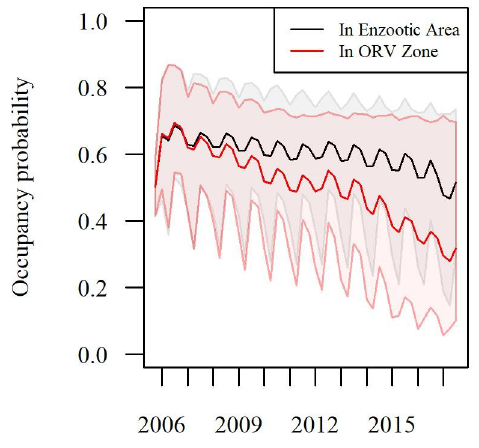
Figure 2. The Probability of RABV occupancy from 2006 to 2017 in the northern counties of New York, Vermont and New Hampshire. The estimates are shown by season and by status of areas within the ORV management zone (red) and those south of the ORV management zone in the enzootic area (black). The shaded regions by color show the 95% confidence intervals.